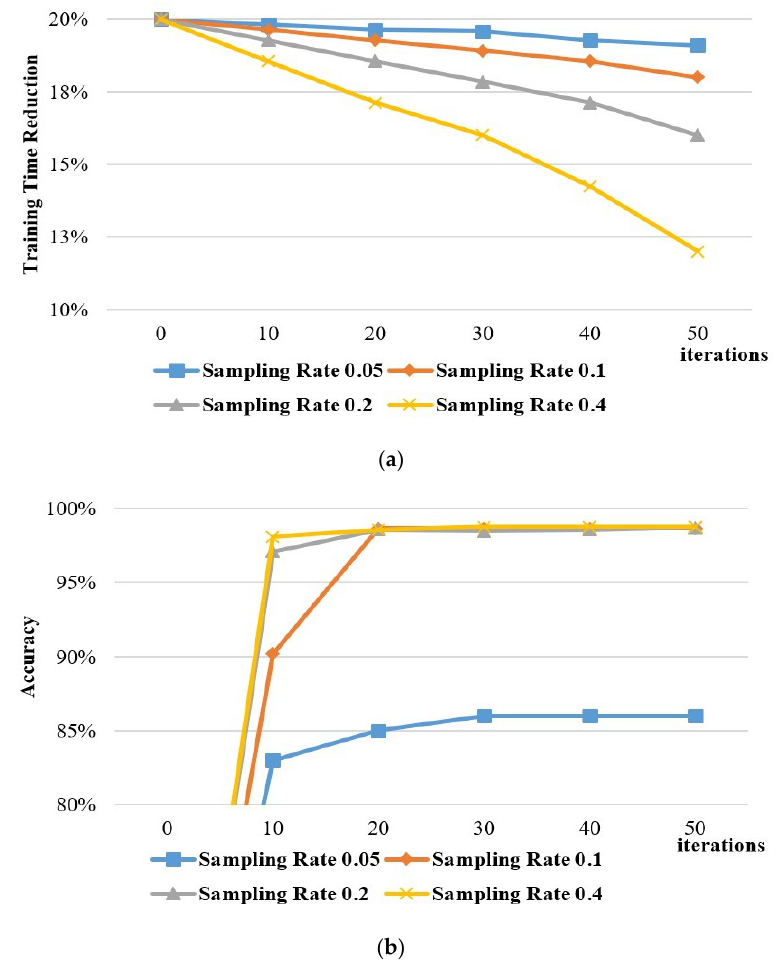
Figure 13. ( a ) Training time reduction and ( b ) accuracy with different numbers of iterations and different sampling rates in MNIST.